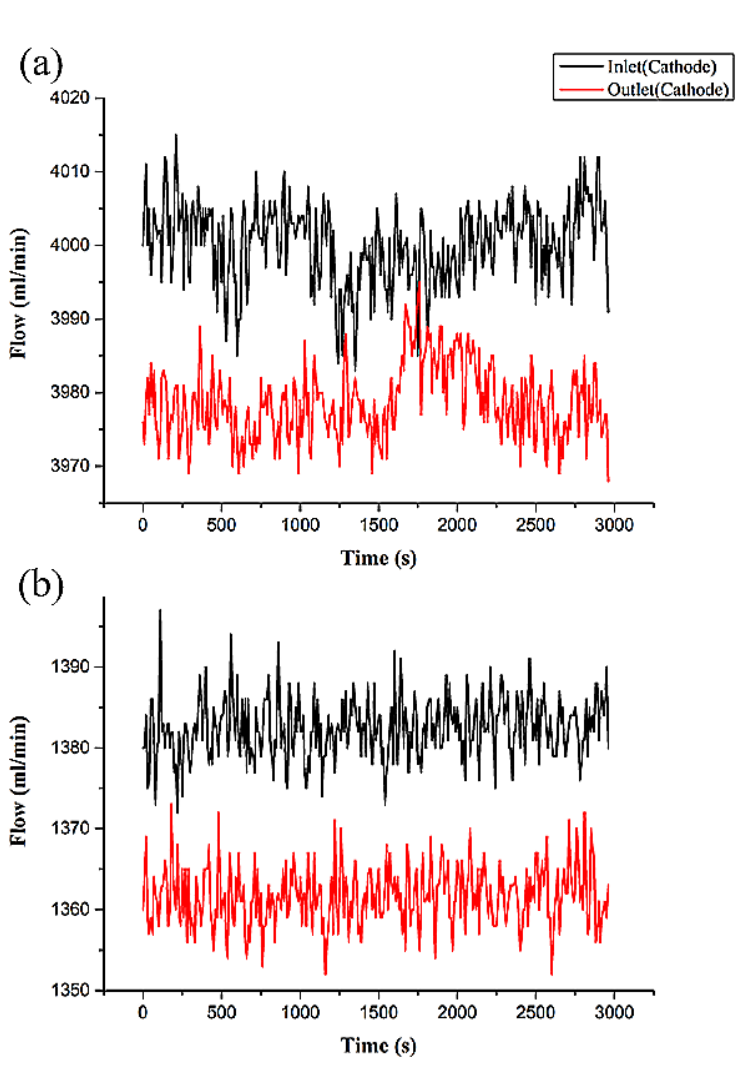
Figure 11. Flow changes of inlet and outlet on ( a ) anode and ( b ) cathode of HT-PEMFCs.